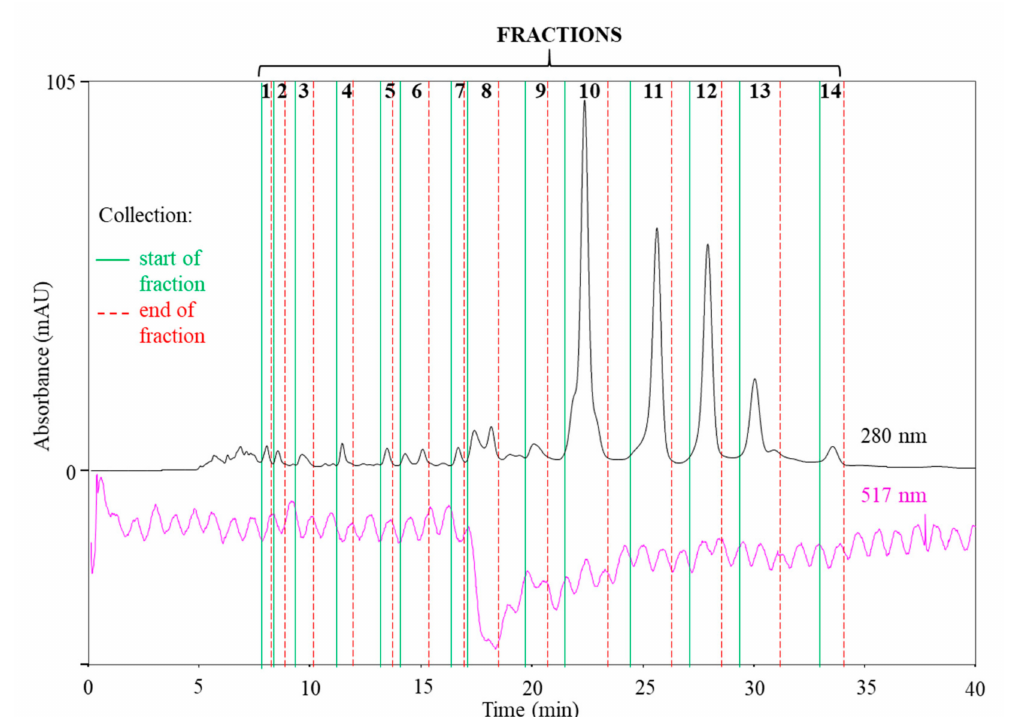
Figure 4. SEC-HPLC-UV/Vis chromatogram at 280 nm (without post-column reaction) and at 517 nm (after post-column reaction with DPPH). The fractions and time intervals selected for fraction collection are marked. Fraction 8 was determined to be the strongest antioxidant due to the decrease in the absorbance at 517